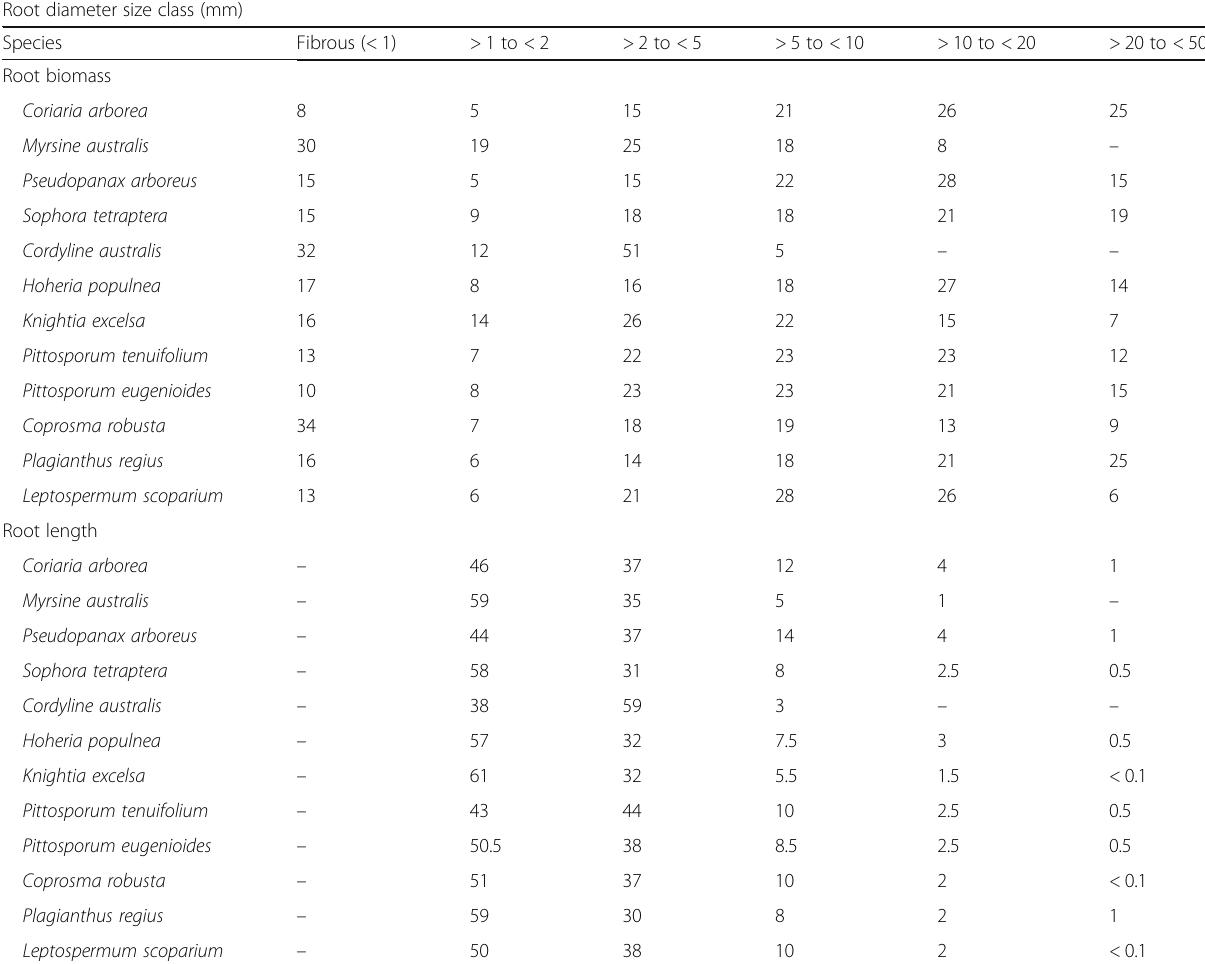
Table 4 Percent of mean total root biomass (g) and root length (m) by diameter size class at year 5 Root diameter size class